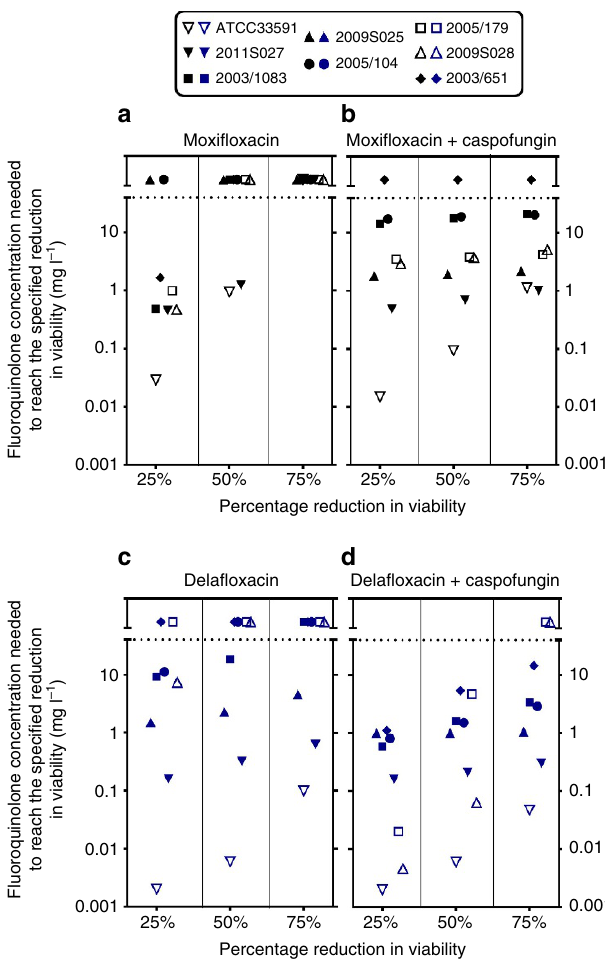
Figure 2 | Relative potencies of fluoroquinolones alone or combined with caspofungin on biofilms. Comparison of relative potencies of fluoro- quinolones alone ( a moxifloxacin; c delafloxacin) or combined with a fixed concentration (40mgl (cid:2) 1 ) of caspofungin ( b and d ) against biofilms. The ordinate shows the concentrations of fluoroquinolones needed to reach 25, 50 or 75% reductions in viability as assessed by measuring residual resorufin fluorescence. Active concentrations were calculated based on the equation of sigmoid concentration–response curves obtained for each strain in experiments similar to those illustrated in Supplementary Fig. 3. Each symbol corresponds to a specific strain, as indicated on the top of the graphs. A lower active concentrations corresponds to a higher potency. The horizontal dotted lines separate values for which calculated concentrations were above the actual maximal fluoroquinolone concentrations tested (20mgl (cid:2) 1